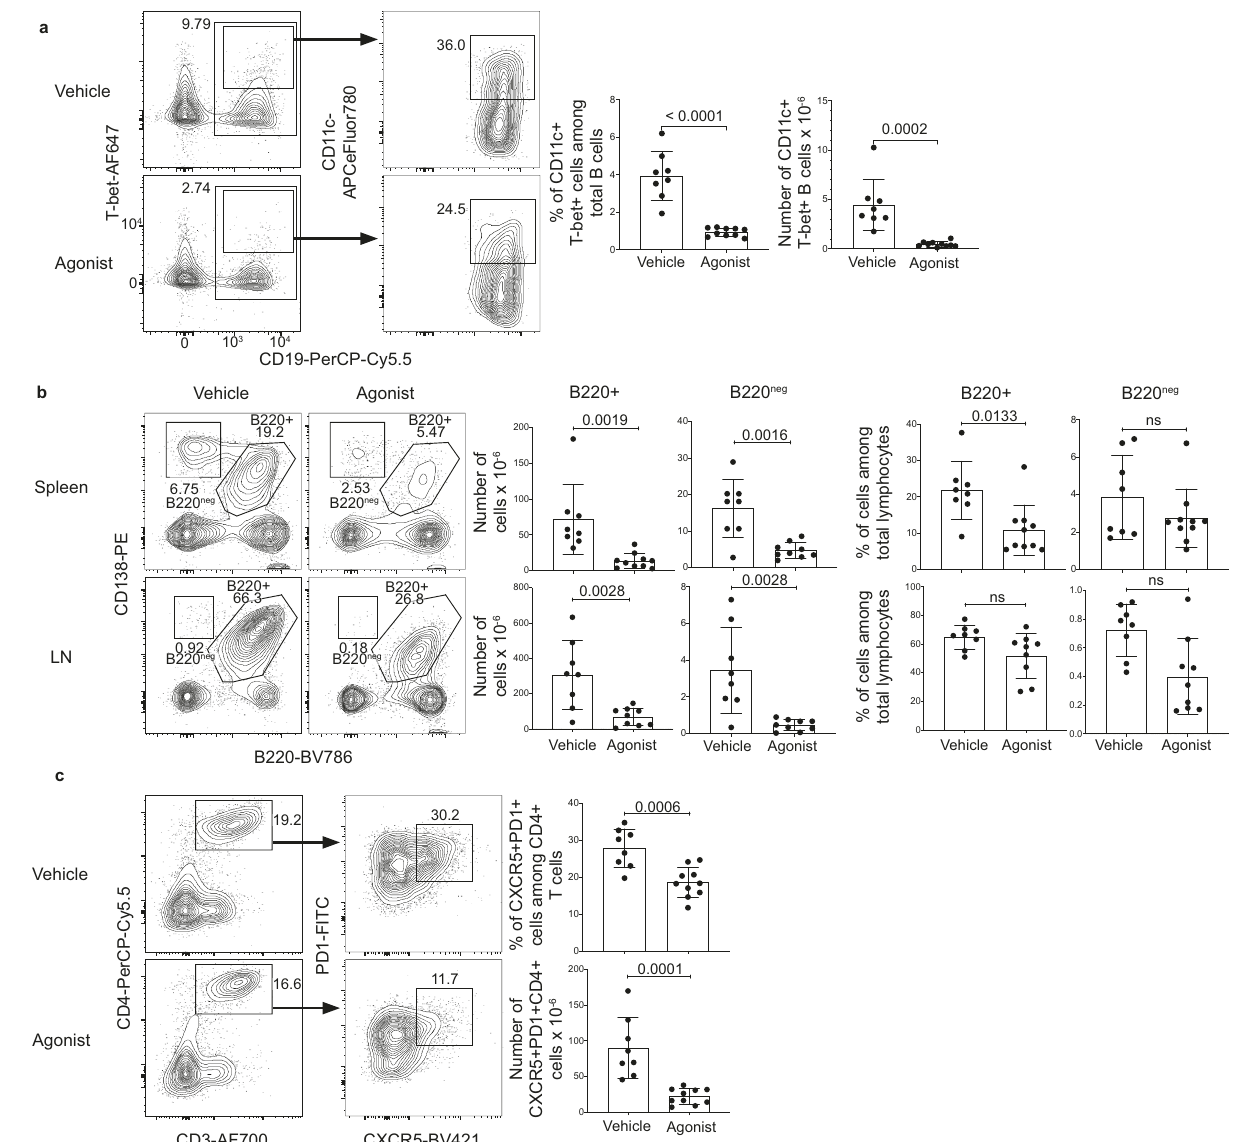
Fig. 2 A 2A receptor agonism depleted CD11c + T-bet + B cells in lupus-prone mice. a Female MRL/lpr mice were treated with vehicle ( n = 8) or agonist ( n = 10) twice weekly, starting at 8 weeks of age; splenocytes were analyzed at 20 weeks of age. The zebra plots and graphs show the percentages and numbers of T-bet + CD11c + CD19 + B cells (%: p < 0.0001; #: p = 0.0002). Statistical signi fi cance was determined using either a two-tailed unpaired t -test (left graph) or a Mann – Whitney test (right graph). b Splenocytes and LNs from the mice in a were analyzed by fl ow cytometry. The contour plots and graphs show the percentages and numbers of CD138 + B220 + cells and CD138 + B220-negative cells in the spleens and LNs of analyzed mice. Statistical signi fi cance was determined using two-tailed unpaired t -tests with the Benjamini, Kieger, and Yekutieli two-stage step-up false discovery rate method. The q values are shown in the graphs. c Splenocytes from the mice in a were analyzed by fl ow cytometry. The contour plots and graphs show the percentages and numbers of PD-1 + CXCR5 + CD4 + CD3 + cells. Statistical signi fi cance was determined using two-tailed unpaired t -tests. Columns and error bars indicate the arithmetic mean and